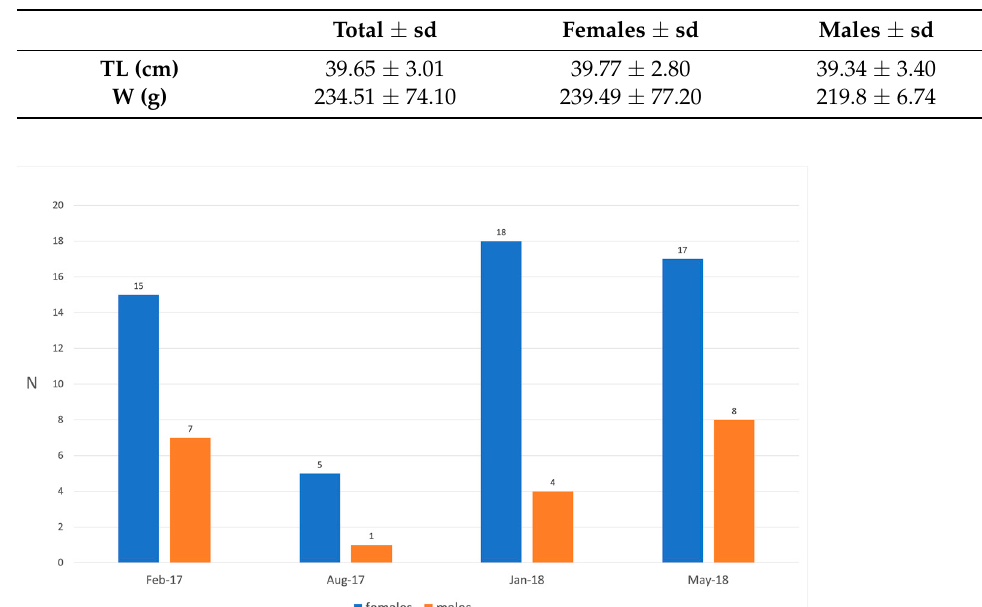
Table 1. Biometric parameters of sampled S. canicula specimens.